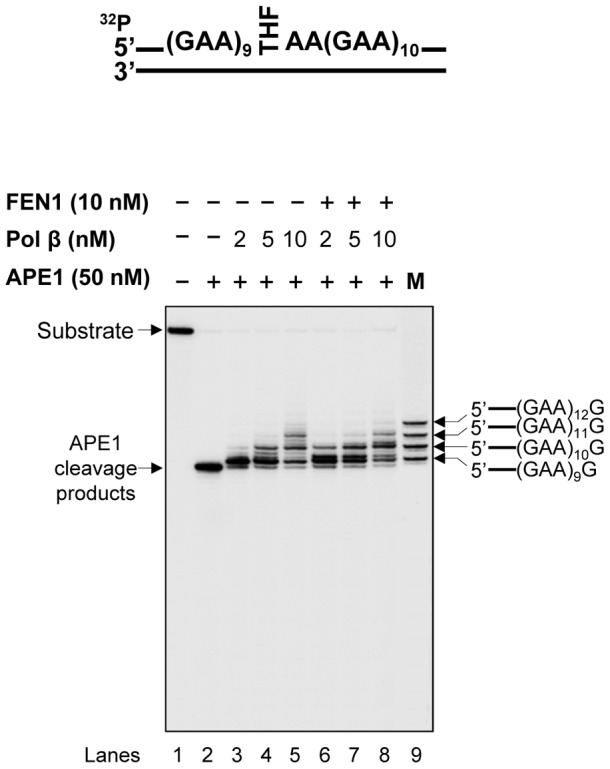
Pol β DNA synthesis during BER of an abasic lesion in the context of (GAA)20 repeats.Pol β DNA synthesis with the (GAA)20 substrate containing an abasic lesion (a THF residue) was determined by incubating the (GAA)20 substrate radiolabled at the 5'-end of the damaged strand with increasing concentrations of pol β in the absence or presence of 10 nM FEN1. Lane 1 corresponds to the substrate only. Lane 2 corresponds to reaction mixtures with 50 nM APE1. Lanes 3–5 correspond to reaction mixtures with 2, 5, and 10 nM pol β in the absence of FEN1. Lanes 6–8 correspond to reaction mixtures with 2, 5, and 10 nM pol β in the presence of 10 nM FEN1. Lane 9 corresponds to synthesized size markers (M). The substrate is illustrated schematically above the gel.